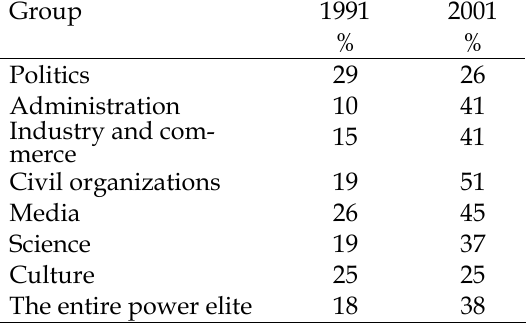
Table 1 . The percentage of the baby boomers (born between 1945 - 50 ) belonging to various elite groups in 1991 and